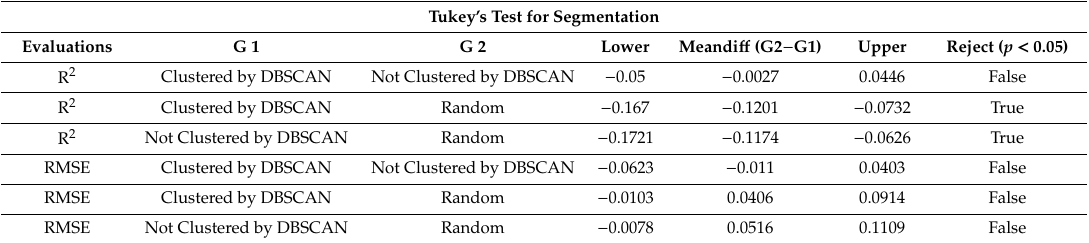
Table6. Tukey’srangetestforpsychographicsegmentationasawholeinunderstandingconsumerpreference.